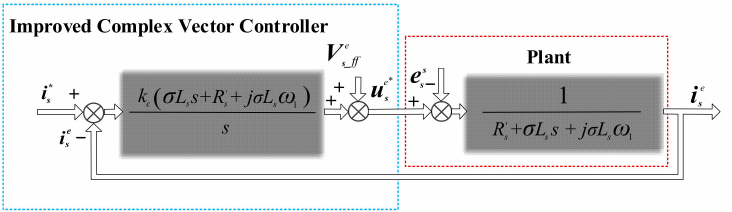
Figure 18. The proposed complex vector current control with delay compensation block